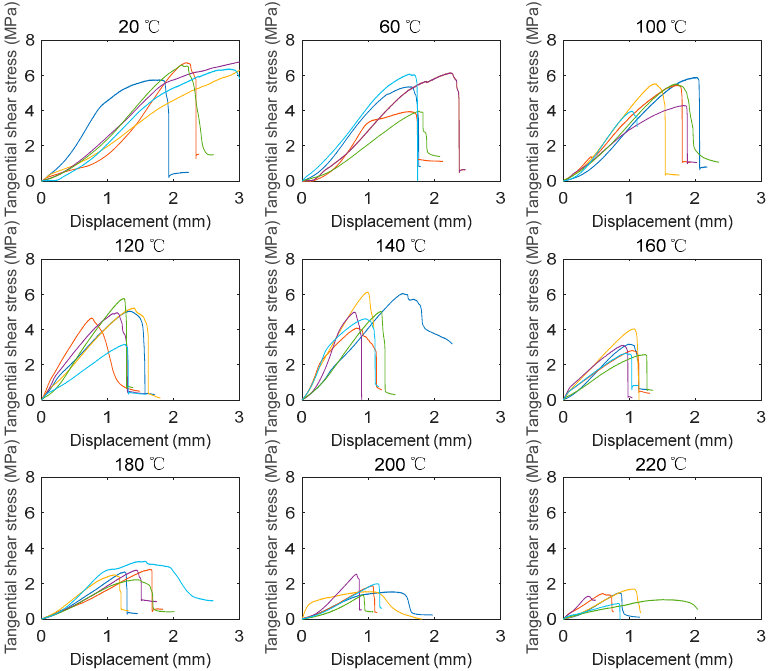
Figure 7. Tangential shear stress–displacement at different elevated temperatures.